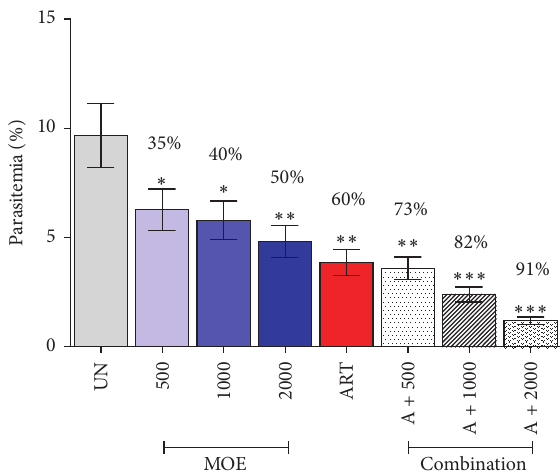
Figure 1: Antimalarial activity of Gynostemma pentaphyllum . Groups of na¨ıve ICR mice (5 mice each) were infected intraperi- toneallywith1 × 10 7 parasitizederythrocytesofPbANKA.Theywere then given orally the extract (500, 1,000, and 2,000 mg/kg) either alone or in combination with artesunate (6mg/kg) for 4 consecutive days. Untreated and artesunate treated mice were used as negative and positive controls, respectively. Parasitemia and suppression percentage were subsequently measured. ∗∗ 𝑃 < 0.01 , and ∗∗∗ 𝑃 < 0.001 , compared to untreated control. UN: untreated control; GPE: G. pentaphyllum extract; ART: 6mg/kg of artesunate; A + 500: combination of 6mg/kg of artesunate and 500 mg/kg of GPE; A + 1000: combination of 6 mg/kg of artesunate and 1000 mg/kg of GPE; A + 2000: combination of 6mg/kg of artesunate and 2000 mg/kg of GPE. The results came from 3 independent experiments.